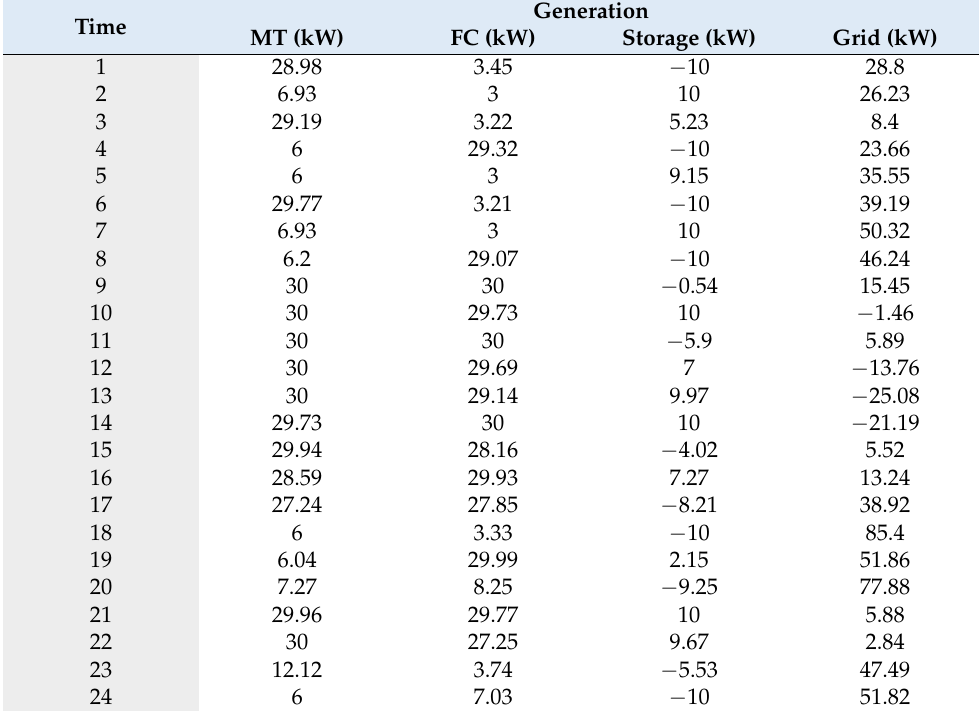
Table 16. Power distribution between generating resources to reduce costs without limiting power exchange total cost